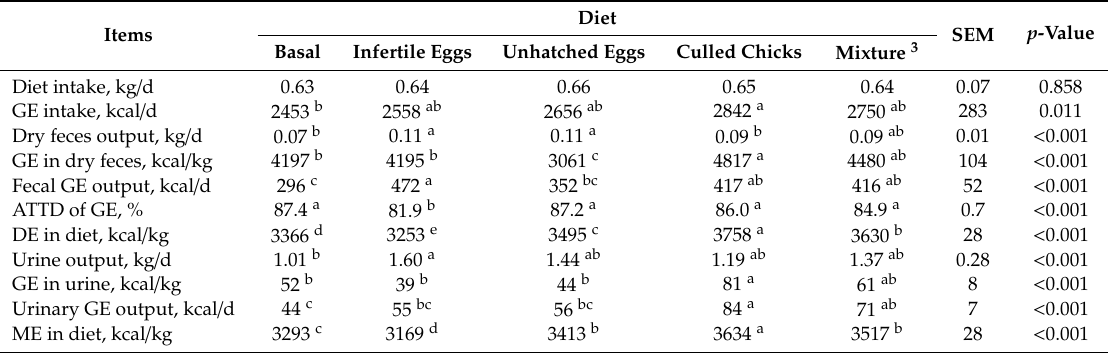
Table 4. Energy digestibility and metabolizability in pigs fed experimental diets (as-fed basis) in Experiment 1 1,2 .